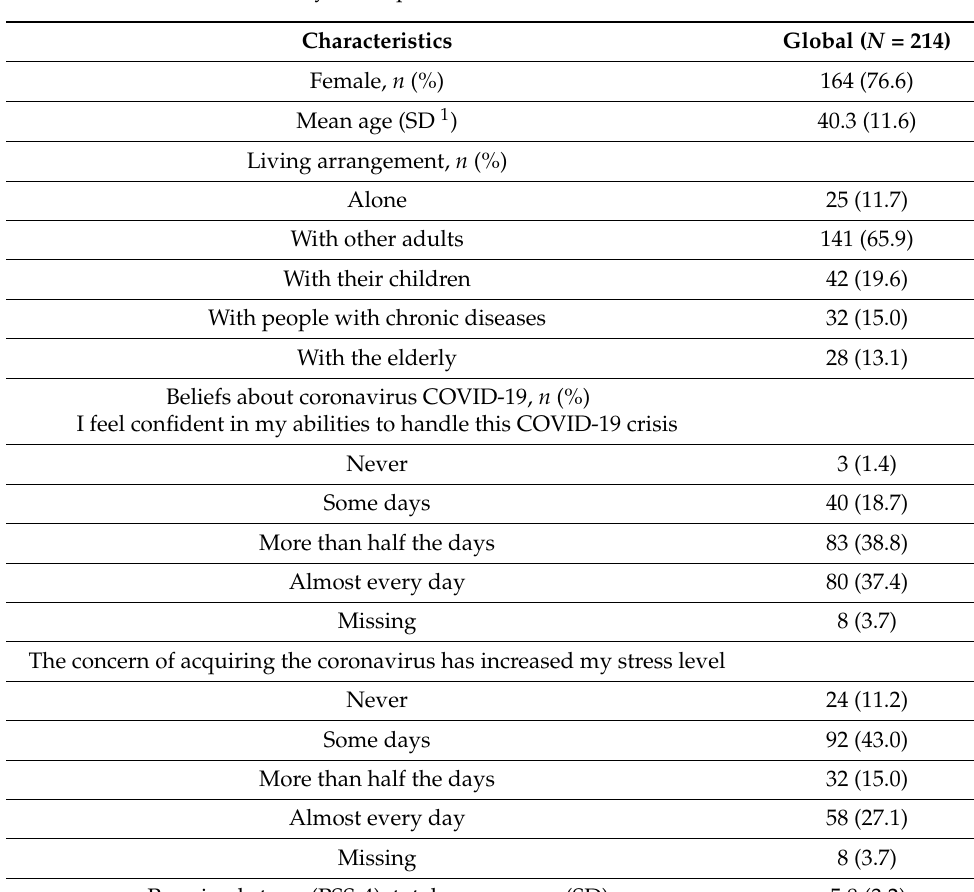
Table 1. Characteristics of Study